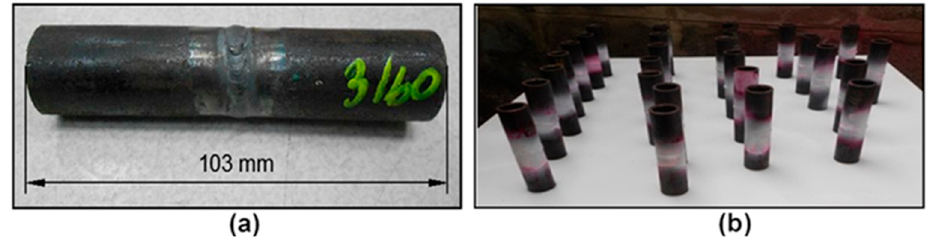
Figure 2. Test pieces ( a ) before and ( b ) after penetrant testing (PT) .